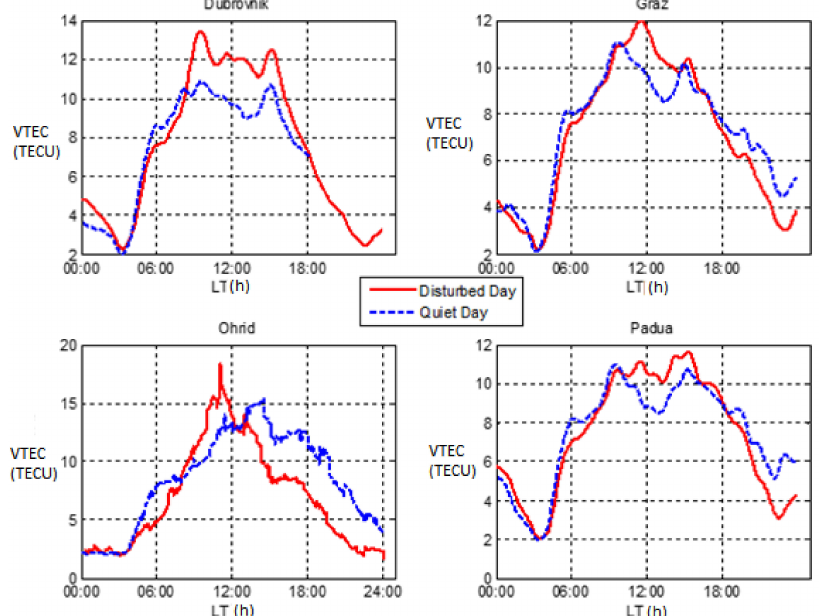
Figure 5. Comparison of diurnal VTEC on Day 114 (disturbed day) and the quietest day of the month (i.e., Kp < 2) for all four stations.